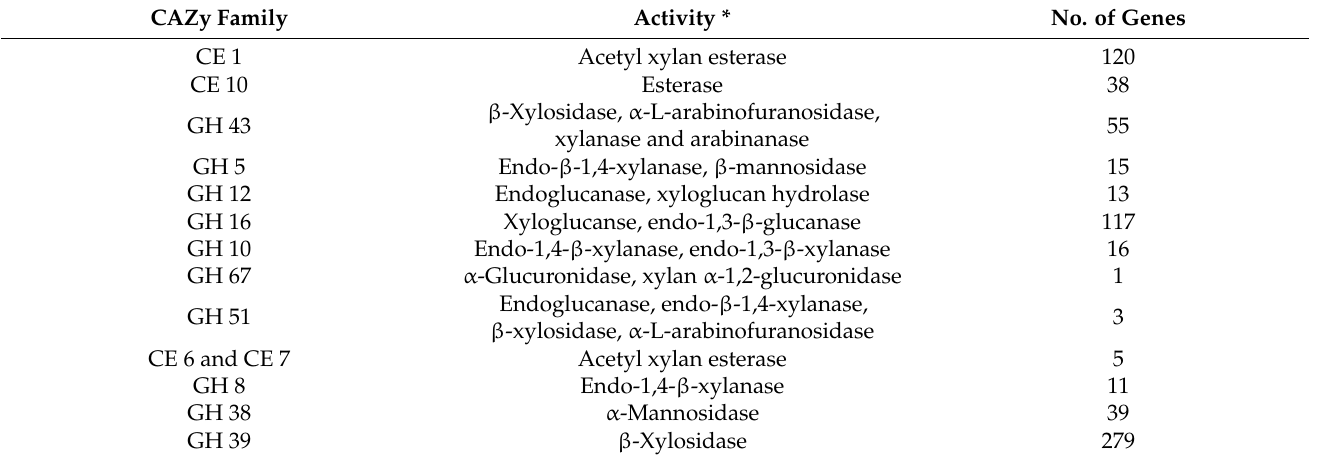
* Protein family function as described on CAZy.org.